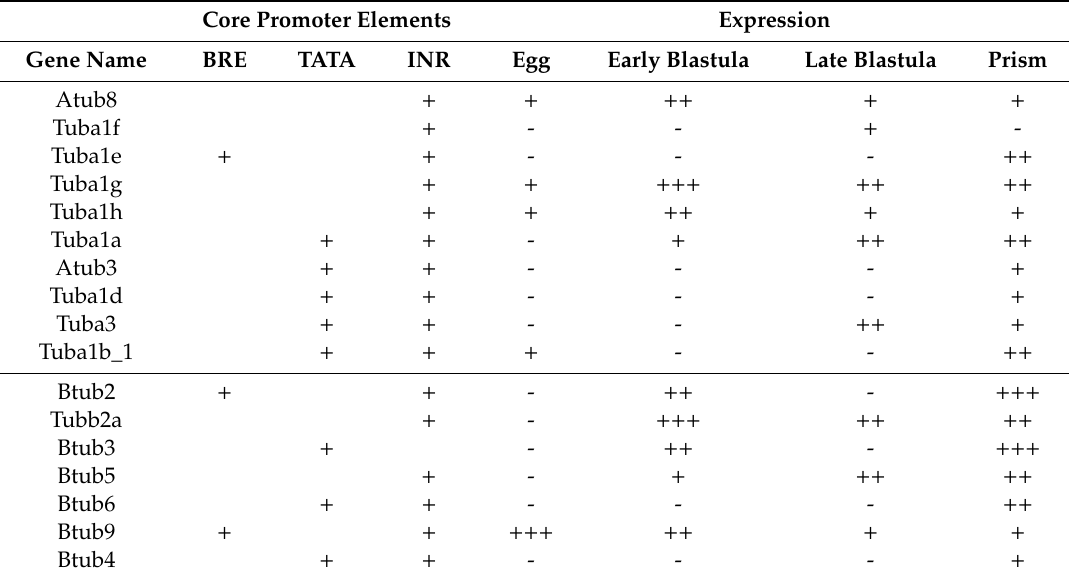
Table 2. Tubulin genes: core promoter elements and expression analysis during development.